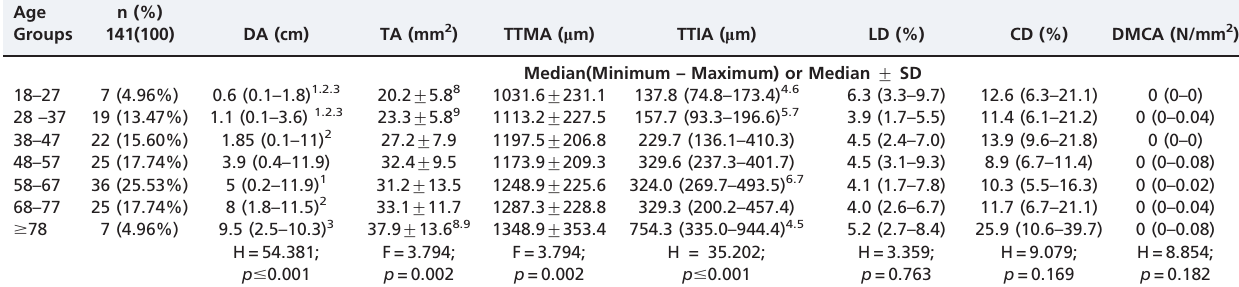
Table 2 - Morphometric analysis of aorta from autopsied patients, according to age groups in 10-year intervals. Age